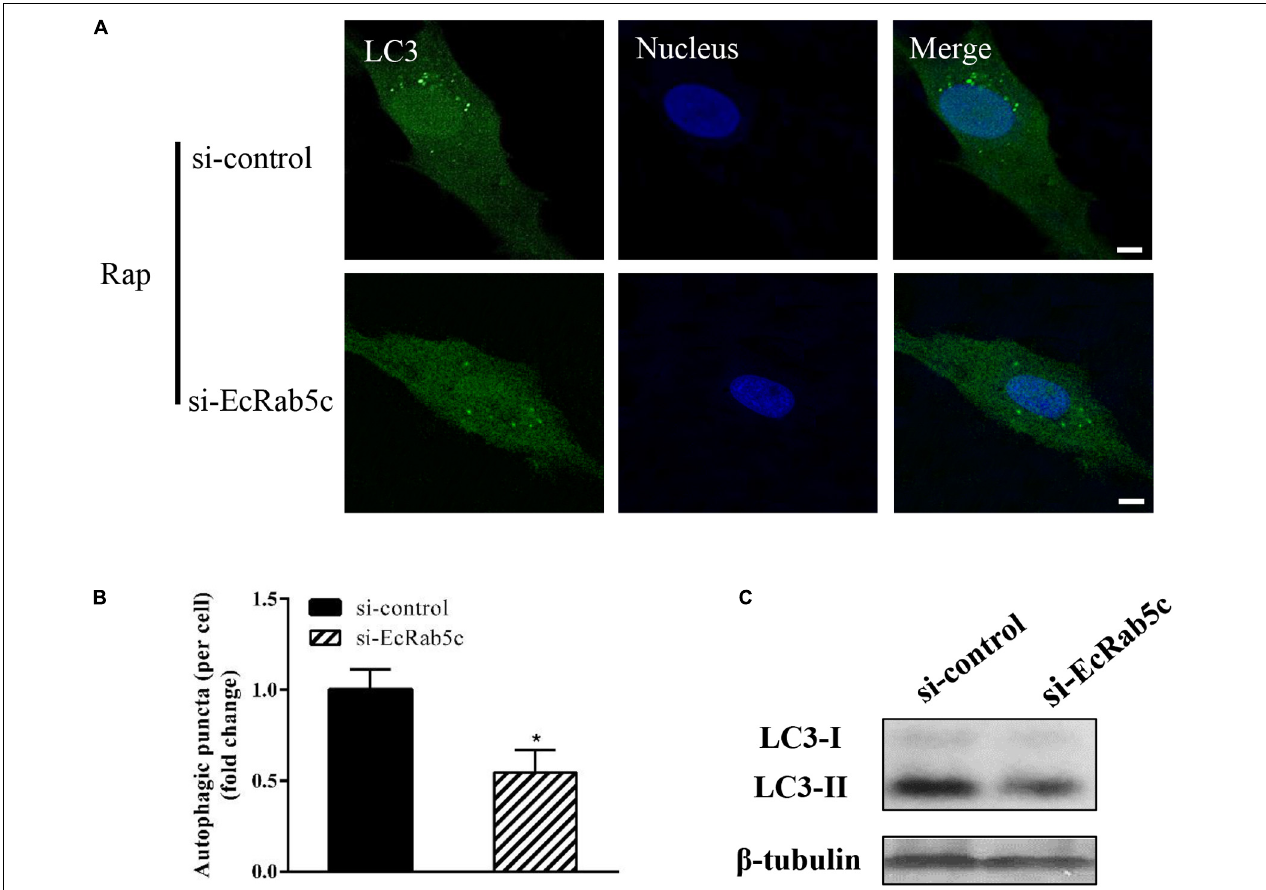
FIGURE 6 | Knockdown of EcRab5c inhibited autophagy. (A) Expression of si-EcRab5c blocked autophagosome formation. GS cells were transfected with si-control/pEGFP-LC3 or si-EcRab5c/pEGFP-LC3, respectively, and then incubated with 1 µ M Rap for 2 h. The nucleus was stained with Hoechst 33342. Scale bars are 5 µ m. (B) Quantification of LC3 puncta/per cell in (A) was expressed as mean ± SEM, n = ∼ 90 cells of 3 independent experiments. * p < 0.05. (C) Expression of si-EcRab5c reduced the level of LC3-II by Western